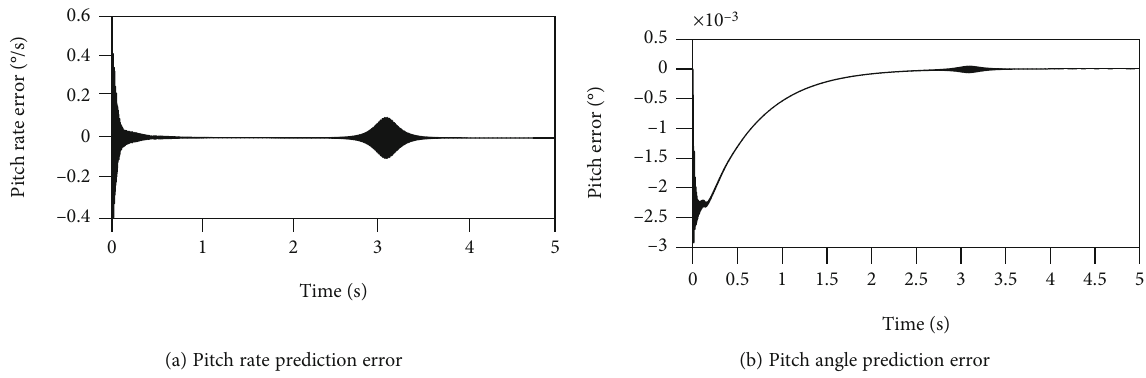
Figure 10: The state prediction error change curves of step response.